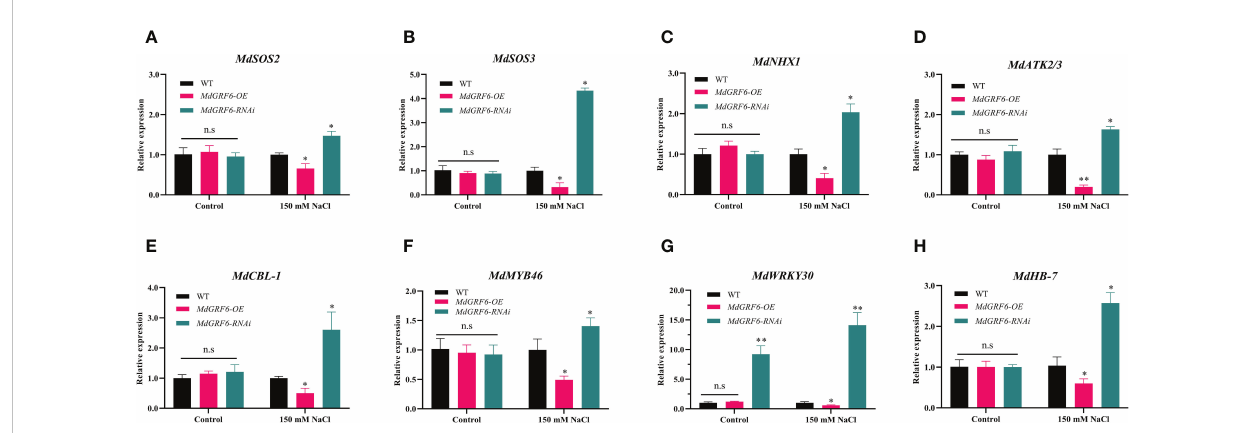
FIGURE 8 MdGRF6 affected the expression of salt stress-related genes in response to salt stress. (A – H) The relative expression of MdSOS2 (A) , MdSOS3 (B) , MdNHX1 (C) , MdATK2/3 (D) MdCBL-1 (E) , MdMYB46 (F) , MdWRKY30 (G) , and MdHB-7 (H) in WT, MdGRF6-OE and MdGRF6-RNAi transgenic calli under control and salt treatments. Error bars indicate the means ± SD (n = 3). The asterisks indicate signi fi cant differences LSD test, ** P < 0.01; * P < 0.05; ns, no signi fi cant